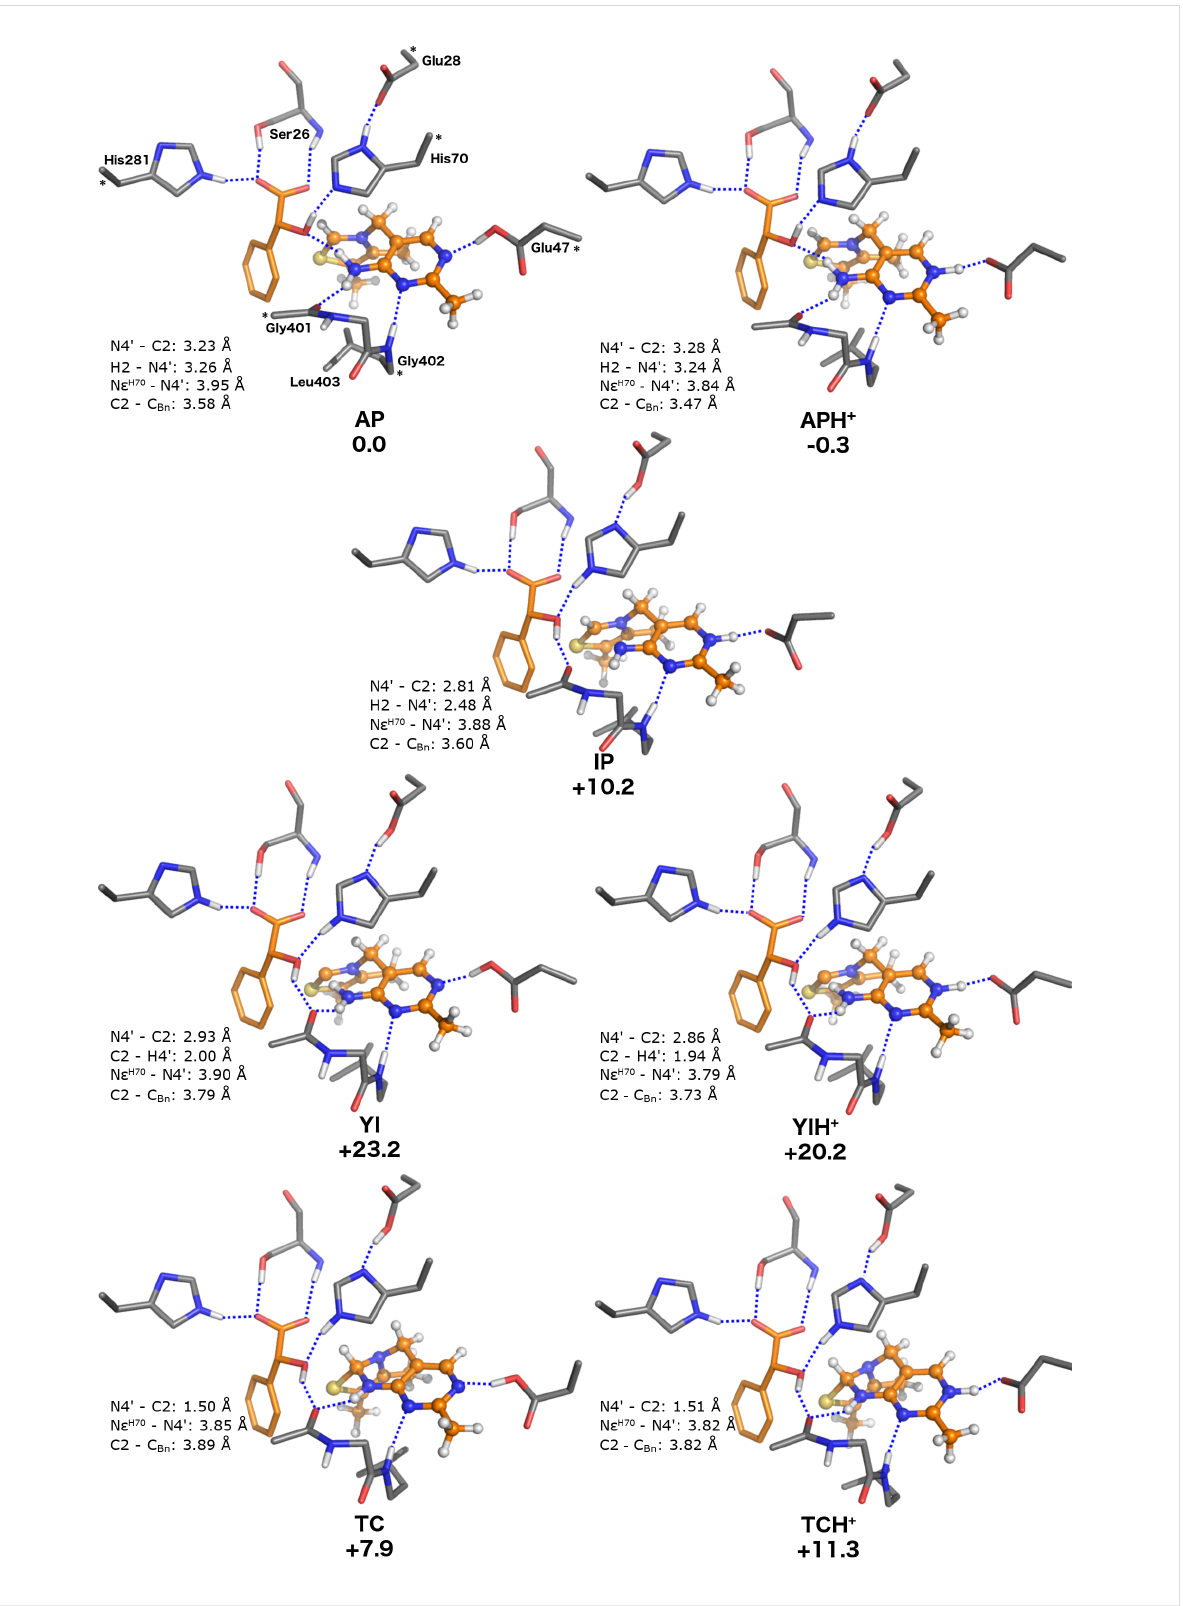
Figure 6: Optimized structures of the ThDP states for the model including ( R )-mandelate (model E ). Relative energies are indicated in